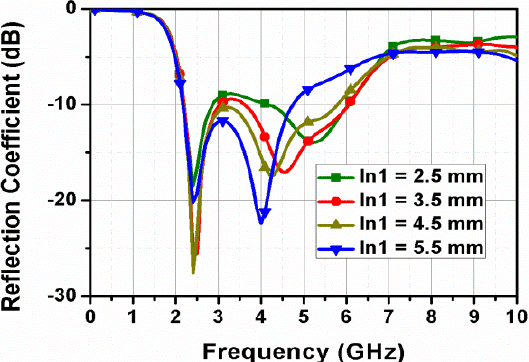
Figure 7. Reflection coefficients of the antennas in intermediate steps of the antenna linked with port 2.